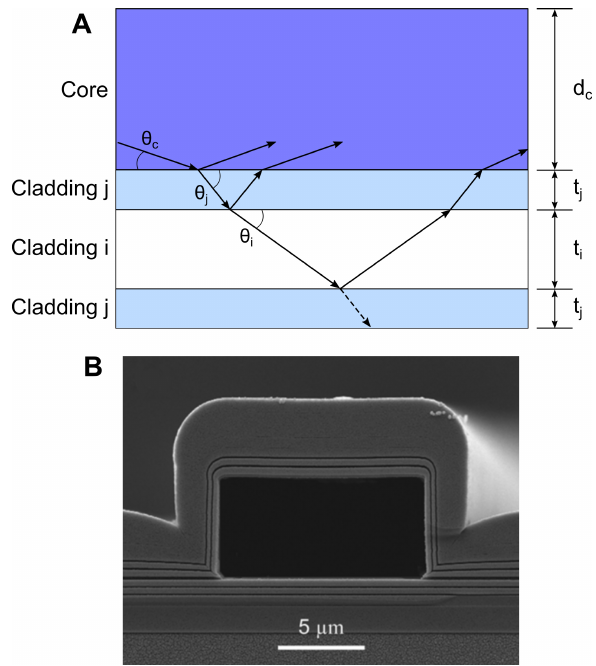
Fig. 3. (A) Cross-section of an ARROW structure showing the antires- onant layers surrounding the core. (B) SEM image of a hollow core ARROW (Source: